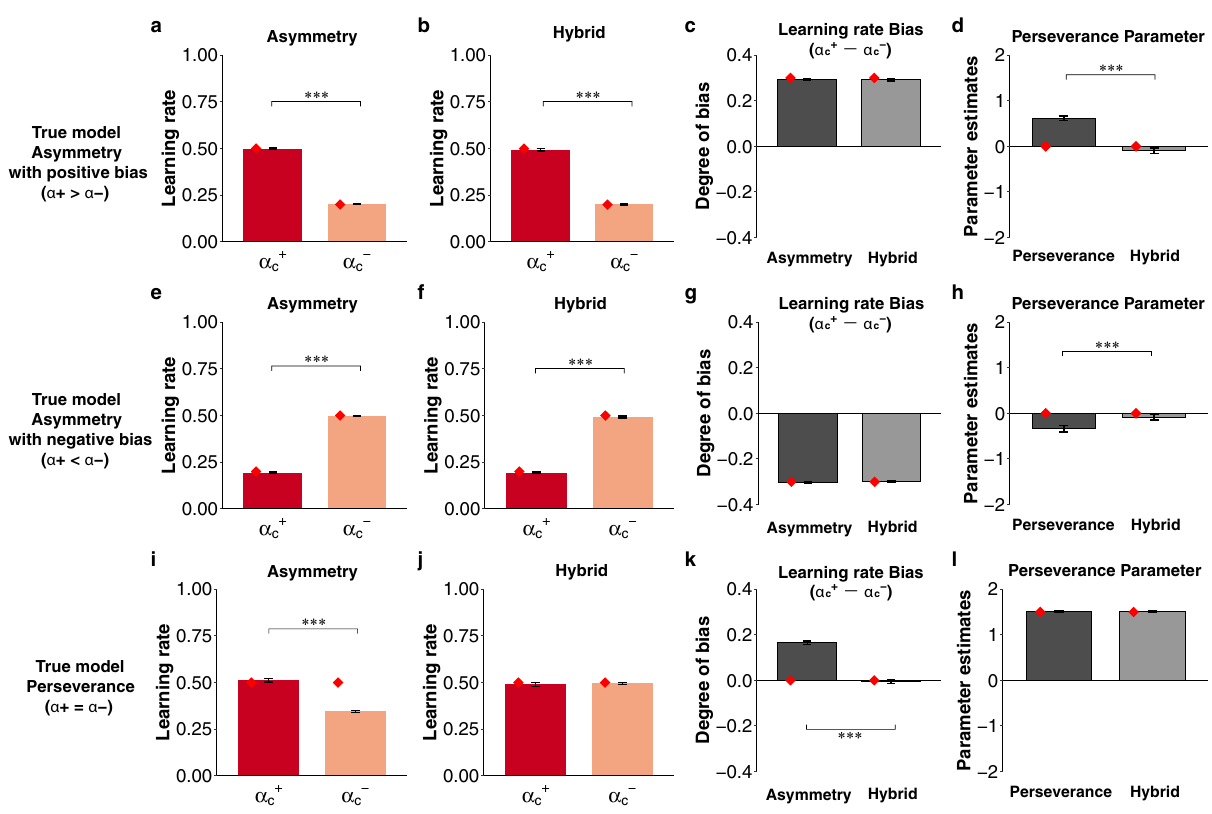
Figure 2. The results of the simulation in the factual learning context. ( a – d ) The results of the true model with asymmetric learning rates assuming positivity bias ( α + c = 0.5, α − c = 0.2 ). ( e – h ) The results of the true model with asymmetric learning rates assuming negativity bias ( α + c = 0.2, α − c = 0.5 ). ( i – l ) The results of the true model assuming symmetric learning rates ( α + c = α − c = 0.5 ) and choice perseverance ( φ = 1.5). ( a , e , i ) The first column indicates the learning rates in the Asymmetry model. ( b , f , j ) The second column indicates the learning rates ( α + c , α − c ) in the Hybrid (gradual) model. ( c , g , k ) The third column shows the degree of learning rate bias ( α + c − α − c ). ( d , h , l ) The final column shows the perseverance parameter ( φ ) in the Perseverance (gradual) and Hybrid (gradual) models. *** p < 0.001, ** p < 0.01 and * p < 0.05. The error bars represent the standard error of the mean. The diamonds denote the ground-truth value of the parameters used in the data